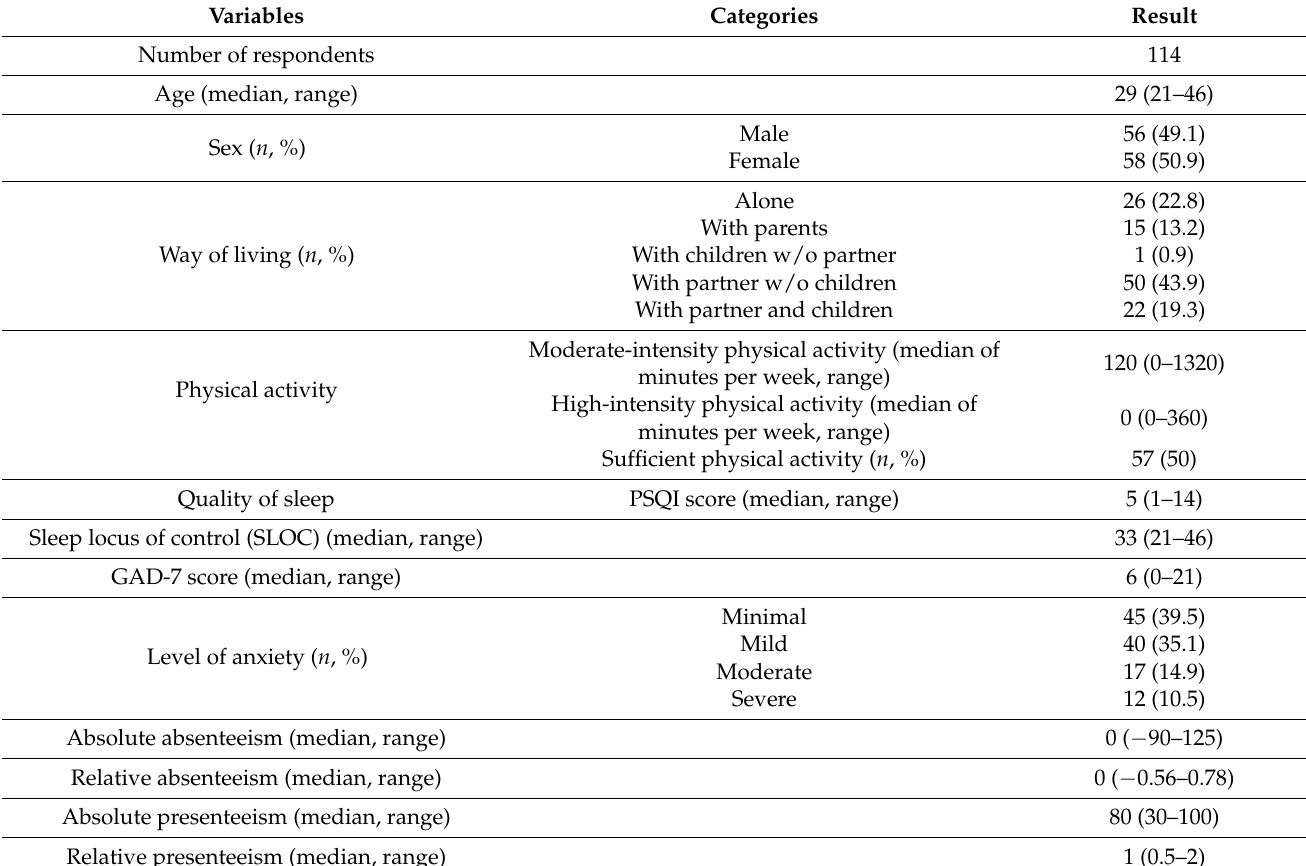
Table 1. Demographic variables and results from the PSQI, SLOC, GAD-7, and WHO HPQ